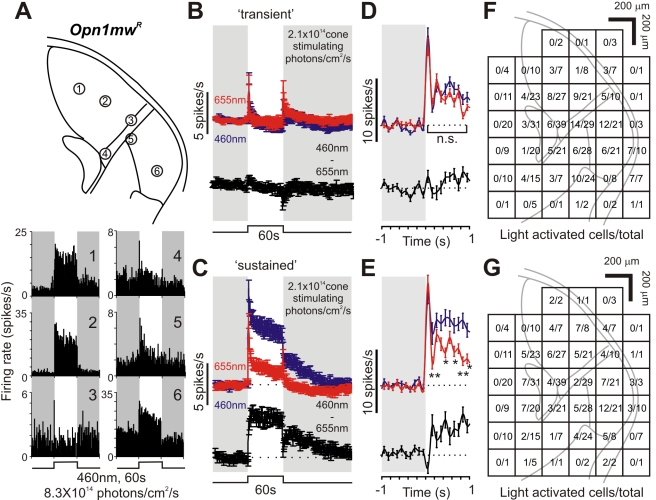
Sustained responses in the lateral geniculate at high irradiances are not driven by cones.(A) Responses of six cells recorded from a representative red cone knockin mouse (Opn1mwR; multiunit data in Figure S5) to 60 s blue light pulses. A subset maintained high firing rates throughout light exposure (cell 1,2,6; “sustained”), while others showed only “transient” responses (cell 3–5). Upper panel represents the probe sites of cells 1–6. (B,C) Average (± SEM) response of “transient” (B) and “sustained” (C) cells (n = 134 and 114, respectively, from 10 mice) to 460 nm/655 nm light pulses isoluminant for cones. Black traces represent the subtraction of the 460 nm and 655 nm responses. Responses to 460 nm and 655 nm light were essentially identical in “transient” cells, whereas “sustained” cells consistently exhibited enhanced responses to 460 nm, consistent with a strong melanopsin input. (D,E) Expansion of the initial “On” transient from (B) and (C) at higher temporal resolution (bin size  = 100 ms), responses of “transient” cells (D) were not significantly different while sustained cells (E) showed enhanced short wavelength responses within 100–200 ms following stimulation (paired t tests, n.s. p>0.05, * p<0.05; ** p<0.01). (F,G) Anatomical distribution of “transient” (F) and “sustained” (G) cells relative to the total number of cells detected (based on 542 units). Both cell types were found in approximately equal proportions in both dorsal and ventral portions of the LGN.